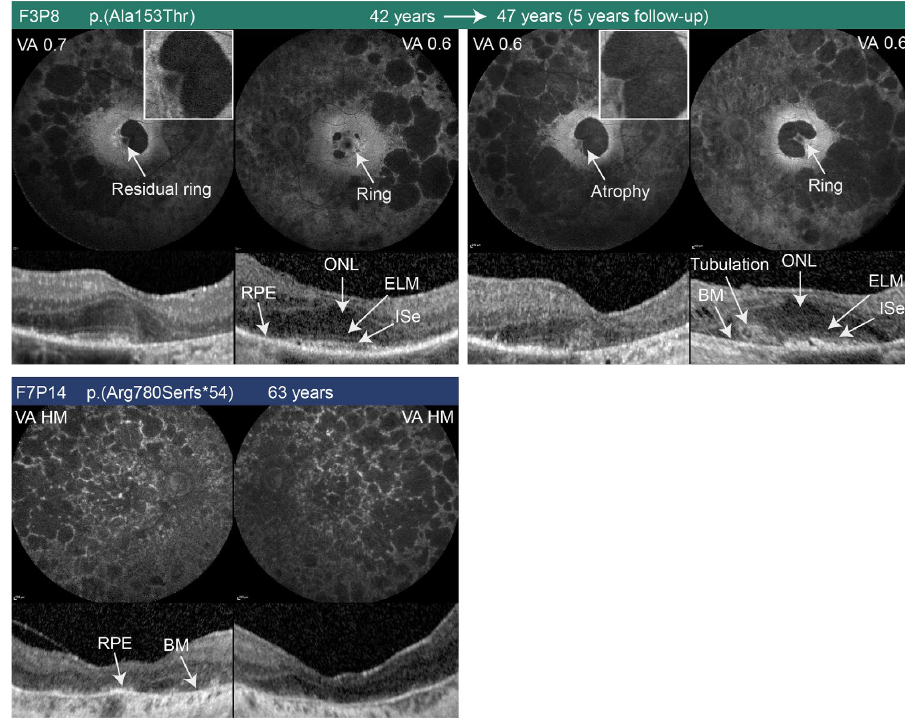
Figure 4. FAF and central OCT of male RP patients from families 3 and 7. Follow-up images are shown for patient F3P8 who presented deterioration in the photoreceptor structure in the fovea with time. Note the photoreceptor tubulation in the area of RPE loss in patient F3P8 that contradicted primary cone loss. HM—hand movement, BM—Bruch’s membrane.